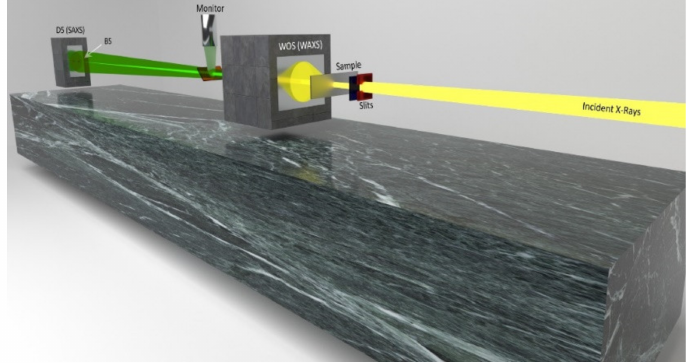
Figure 4. Experimental setup of a simultaneous SAXS/WAXS experiment on the SAXS bench of the D2AM beamline. The X-ray beam is focused on the beam stop (BS) positioned in front of the D5 detector. Scatter-less slits are usually mounted 10 cm away from the sample. A photomultiplier is used as a monitor with a retractable kapton